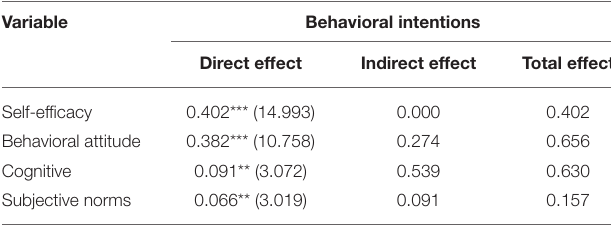
TABLE 6 | Effects of attitude, cognition, self-efficacy, and subjective norms on behavioral